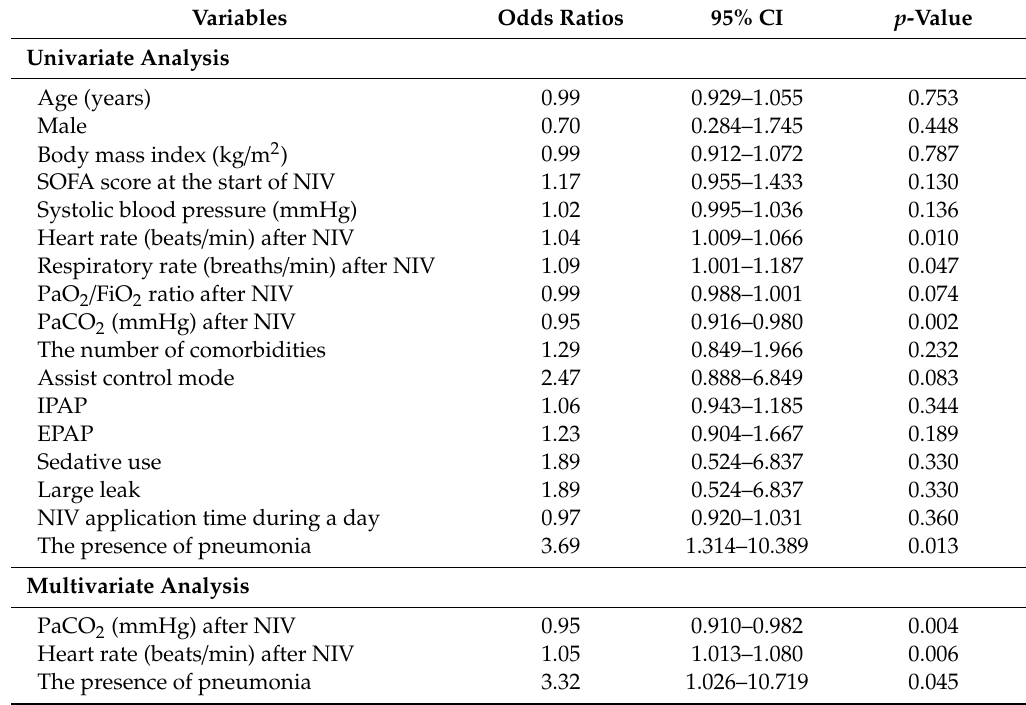
Table 4. Factors analyzed for e ff ects on NIV success /